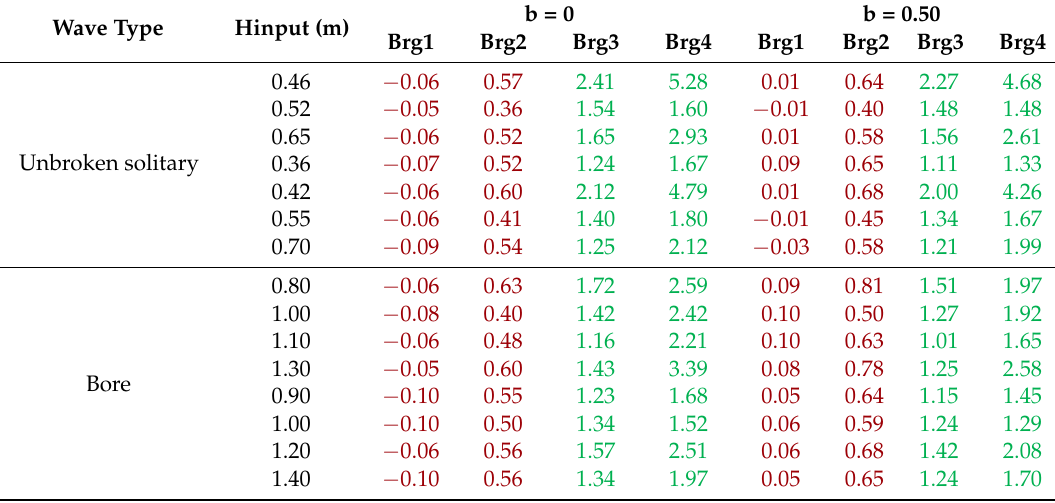
Table 7. Ratios of bearing forces calculated from load case 3 of the improved method to the respective values recorded in the